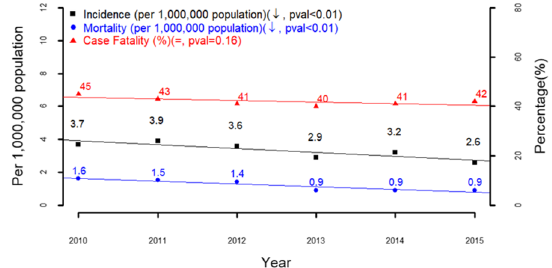
Fig. 1 Incidence, mortality and case fatality of pneumoccocal